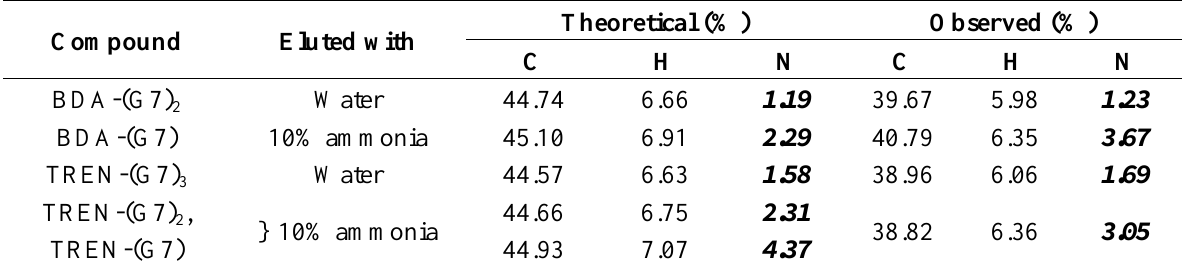
Table 1. Elemental analysis results after purification with Amberlite IR-120 (H + ).